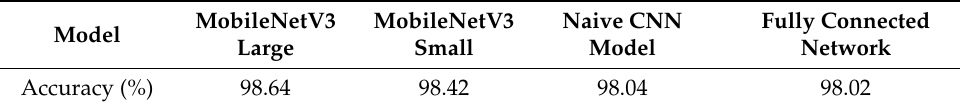
Figure 20. Sample rotation test of the model. Table 6. Orientation recognition rate of the model to the rotated sample.